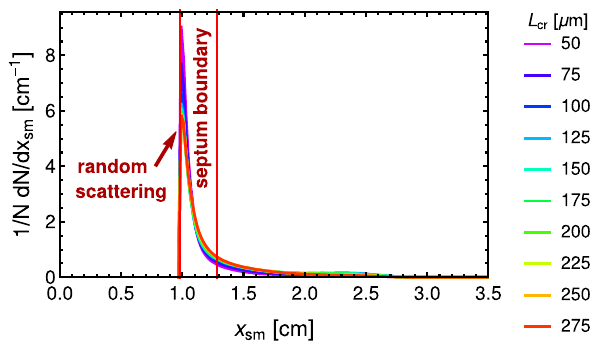
Fig. 13 Multi-turn transverse coordinate distributions of the beam deflected by a bent crystal at the position of the septum magnet for different crystal thicknesses and Si crystals bent along the (111) planes with a deflection angle of 1.75 mrad after 100 revolutions in the accel- erator. The vertical lines indicate the septum magnet boundary, both angular and energy cuts are applied